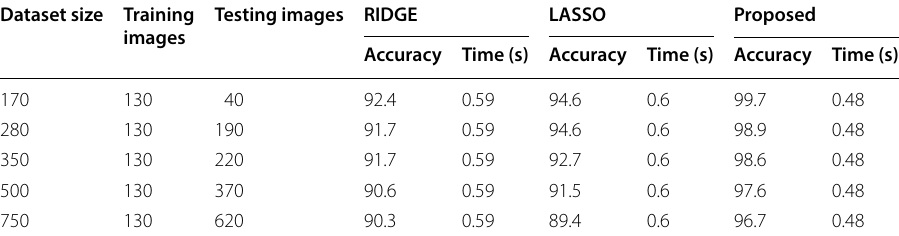
Table 3 Accuracy and Time comparison of 3proposing classification algorithms with MSIFT features training based on Multi-variant principle for FERET database comparing